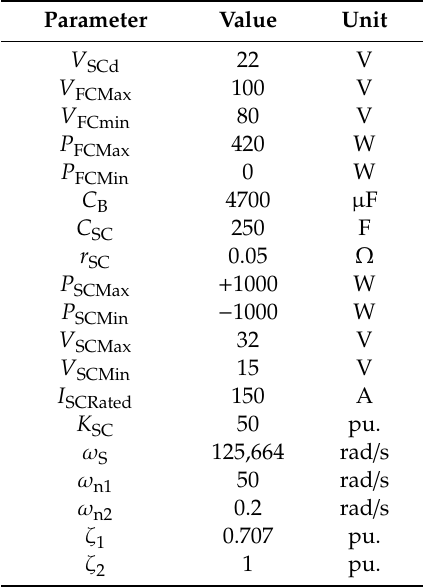
Figure 15. Experimental test rig realized at the GREEN laboratory, Université de Lorraine. Table 1. Summary of the control parameters.